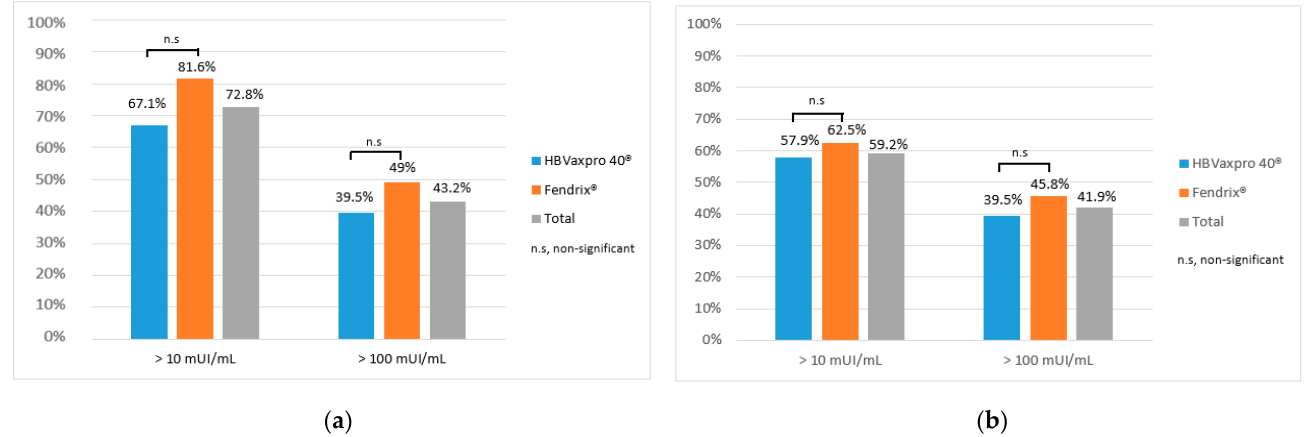
Figure 4. HBV vaccine response at six and twelve months. ( a ) HBV vaccine response at six months; ( b ) HBV vaccine response at twelve months. n.s, non-significant. Table 3. Comparison of patient characteristics between responders and nonresponders to HBV vac- cination by univariate analysis at six months.